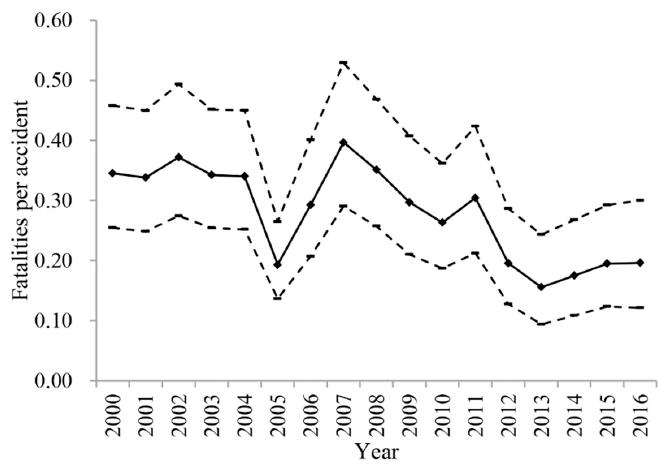
Figure 4. Uncertain time series of fatalities per accident.